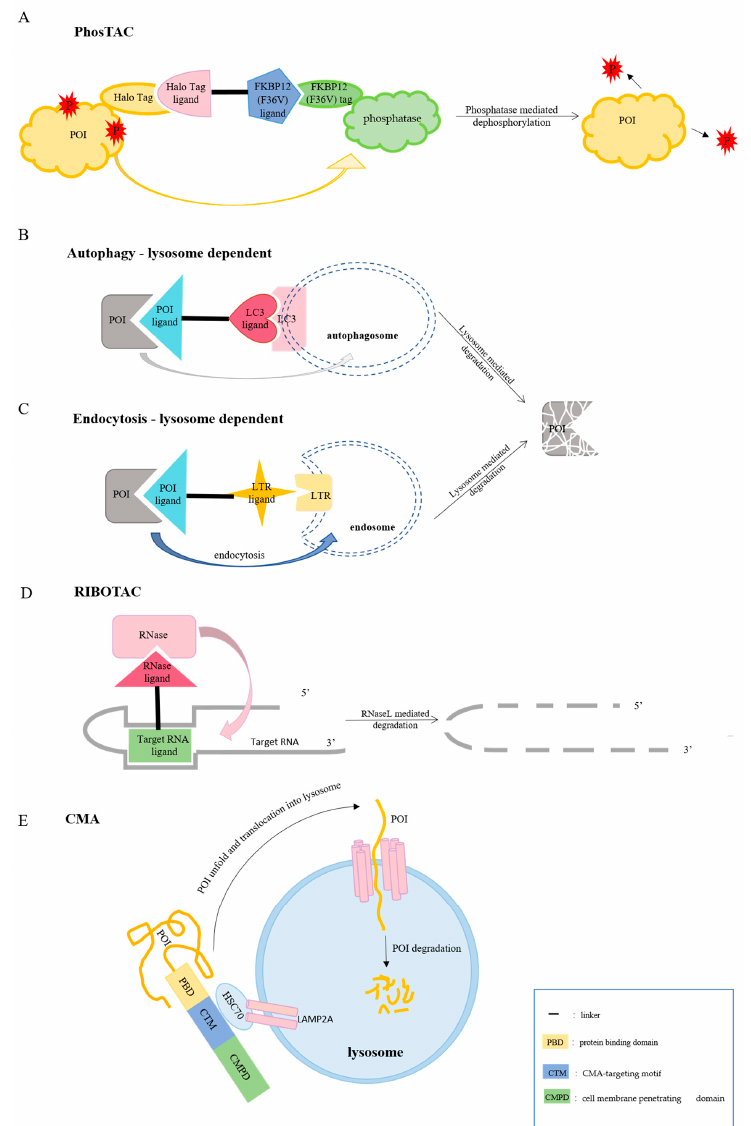
Figure 3. Schematic diagram of targeted degradation strategies based on other mechanisms. ( A ) PhosTAC induces dephosphorylation of POI. The mechanism is that the Halo Tag ligand of PhosTAC can specifically bind to the POI fused with HaloTag, and another FKBP12 (F36V) ligand can recruit the phosphatase fused with FKBP12 (F36V) tag. Ultimately, phosphatases catalyze the dephosphorylation of POI. ( B ) Autophagy–lysosome-dependent PROTACs connect the POI with LC3, a specific protein on the surface of the autophagy, then wrap the POI into the autophagosome, and finally transport it to the lysosome for degradation. ( C ) LYTACs can specifically bind to extra- cellular/membrane POI, and bind to the lysosomal targeting receptor LTR of the cell membrane, so that POI enters the endosome through endocytosis and finally enters the lysosome for degradation. ( D ) RIBOTACs specifically recruit the endogenous ribonuclease RNase L to a specific RNA target, and then successfully eliminate the RNA by RNaseL. ( E ) The CMA-based chimeric peptide contains protein binding domain (PBD) and CMA-targeting motif (CTM), which can respectively bind to POI and HSC70. In addition, the chimeric peptide also contains a domain that facilitates membrane penetration, named CMPD. When HSC70 interacts with LAMP2A on the surface of the lysosomal membrane, the POI unfolds and enters the lysosome, where it is finally